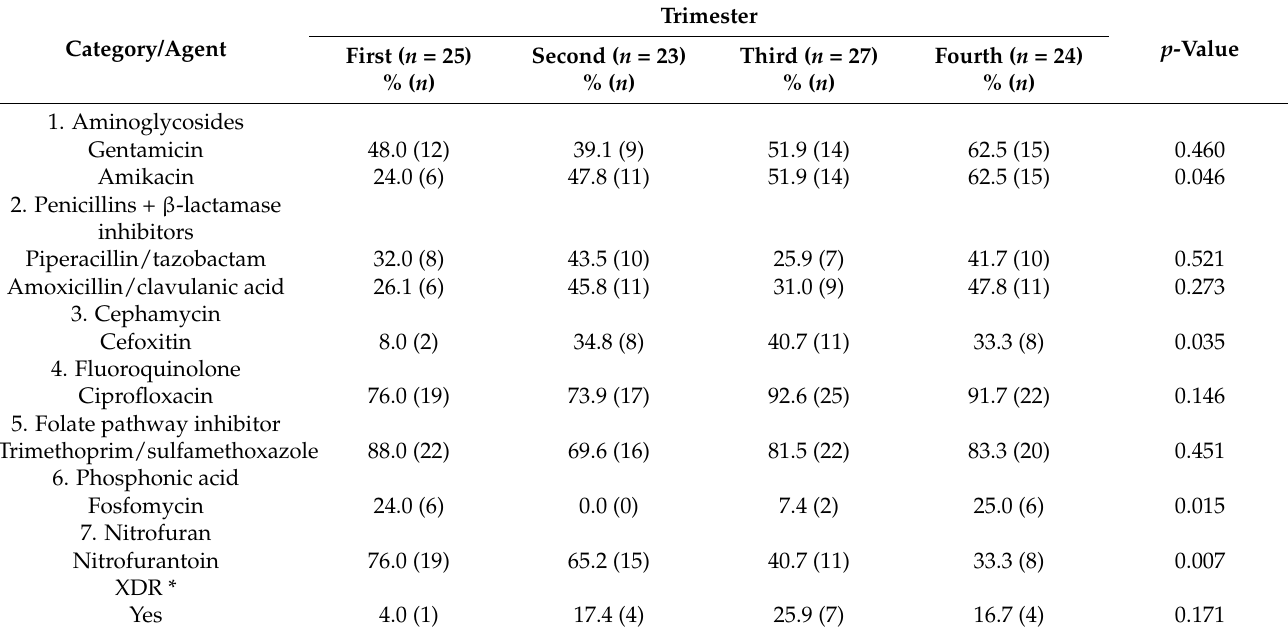
Table 3. Antimicrobial resistance rates of ESBL-producers across the study